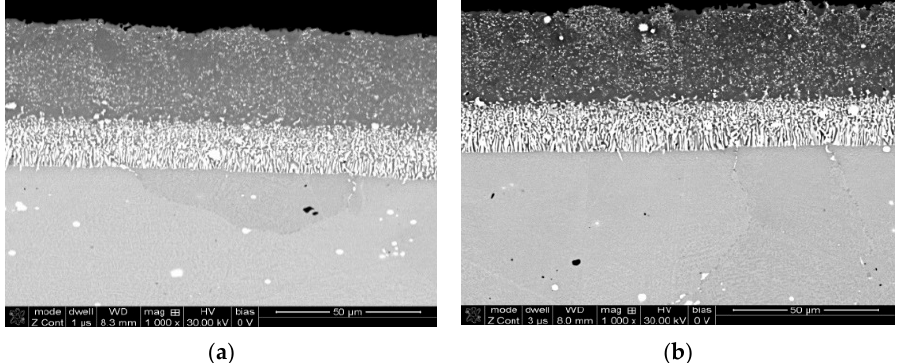
Figure 6. Aluminide layer structure—temperature of 1323 K for: ( a ) 2 h, ( b ) 3 h (Reprinted with permission from Ref. [2] . 2012, AFIT.).